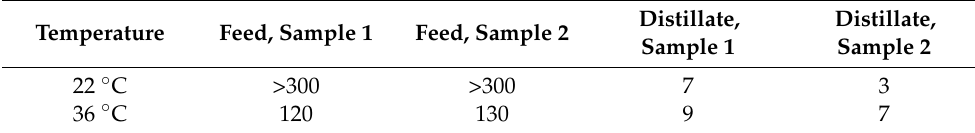
Table 7. Total bacteria count according to TVO, (CFU/mL).